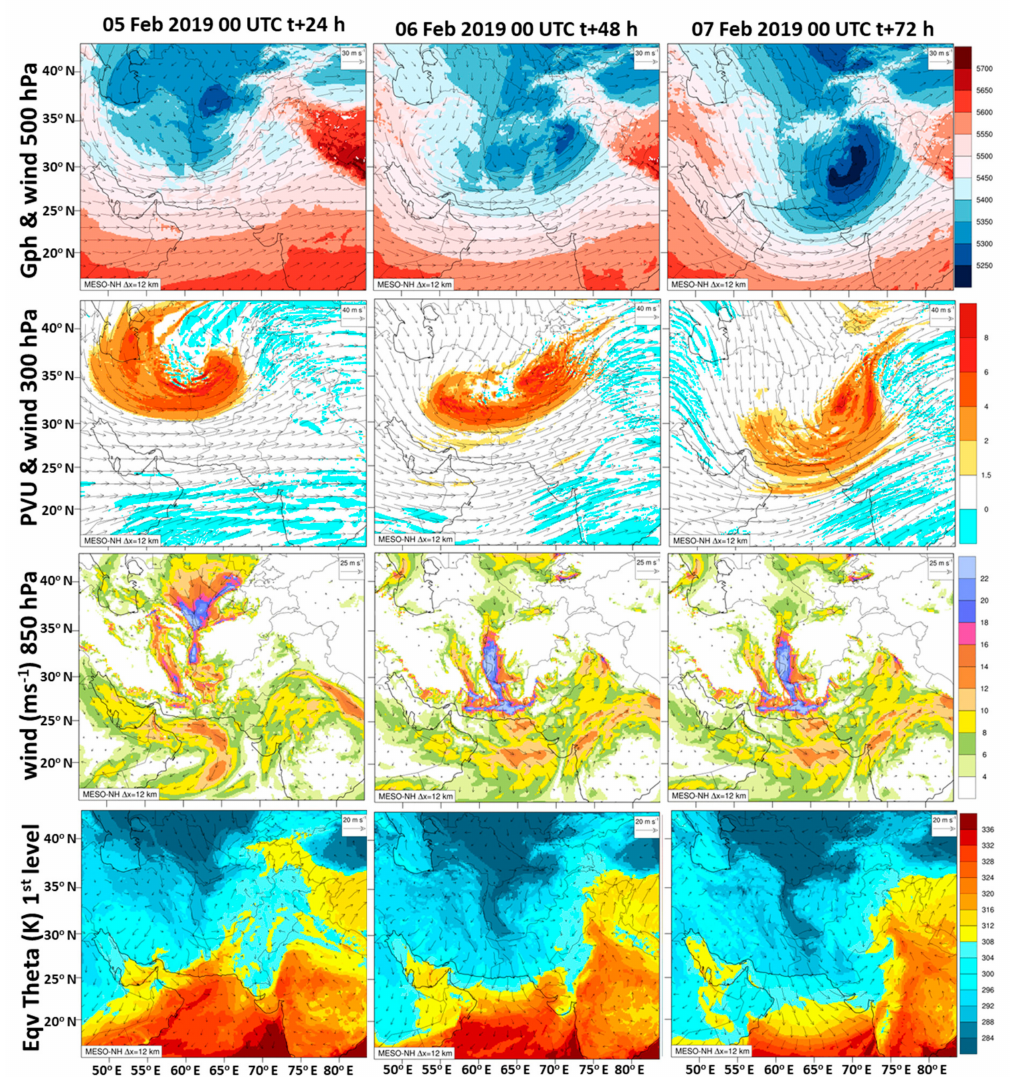
Figure 6. Meso-NH simulations of the geopotential height and vector wind at 500 hPa (first row), potential vorticity and vector wind at 300 hPa (second row), wind speed at 850 hPa (third row), and equivalent Theta (forth row) over southwest Asia during 5–7 February